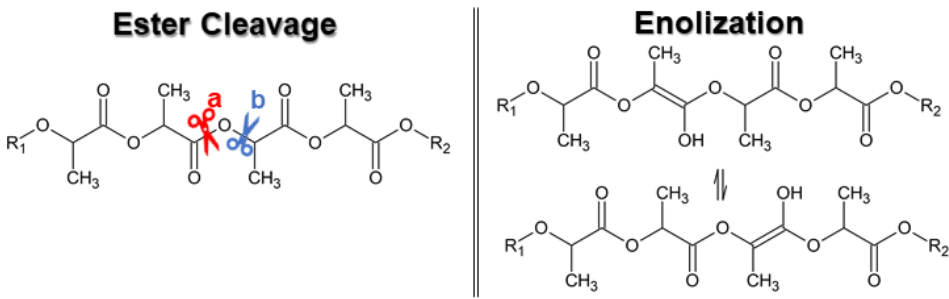
Figure 5. Ester cleavage: (a) carbonyl-oxygen bond, and (b) alkyl-oxygen bond (reprinted with permission [19], Copyright 1997 American Chemical Society); and enolization.